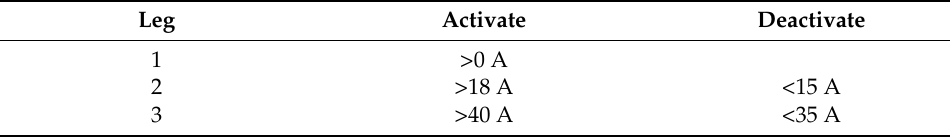
Figure 7. Full converter efficiency with one, two, or three switching legs. Table 4. Current level threshold to activate or deactivate a